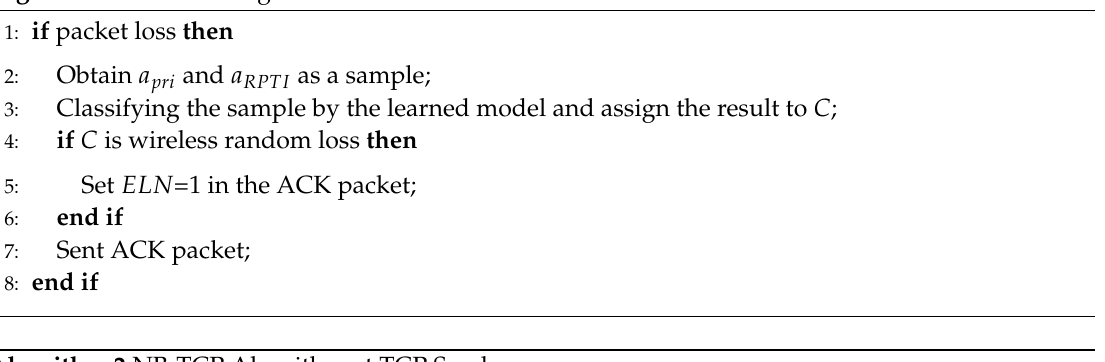
Algorithm 2 NB-TCP Algorithm at TCP